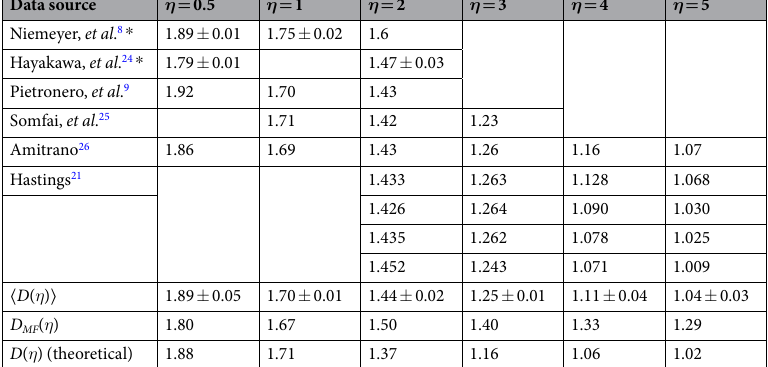
Data source η = 0.5